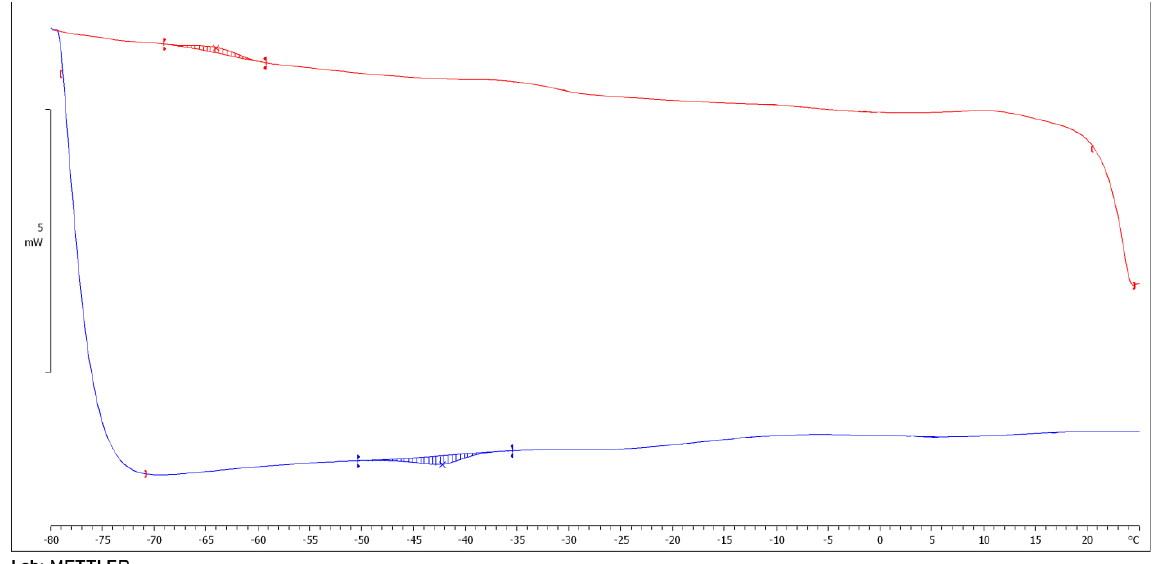
Figure 6. DSC curve of butyl butoxyethyl adipate.